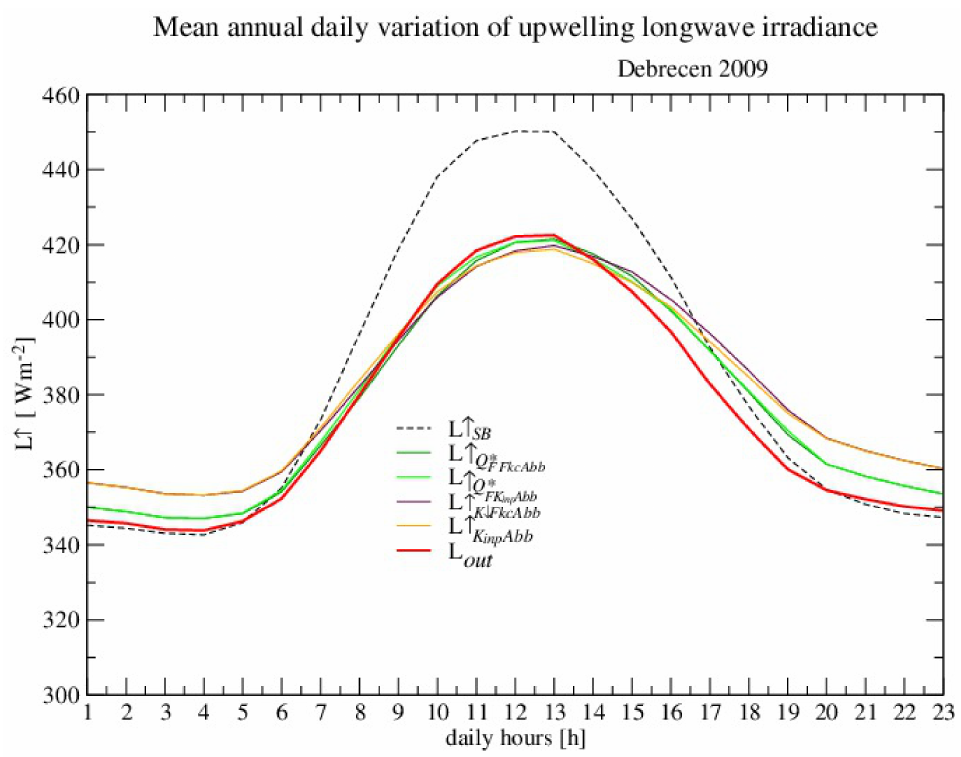
Figure 6. Mean annual daily variation of L ↑ for four models and measurements. Models that used routine meteorological measurements included, separately: K ↓ Fkc or K inp . Abbreviations of the models are same as in Table 9.